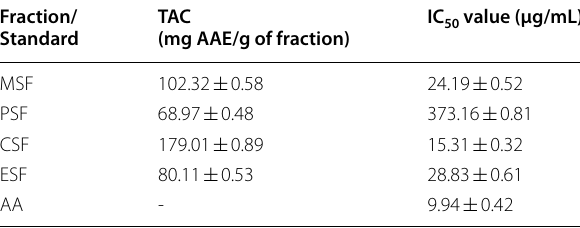
Table 3 Correlation of total phenolic and flavonoid